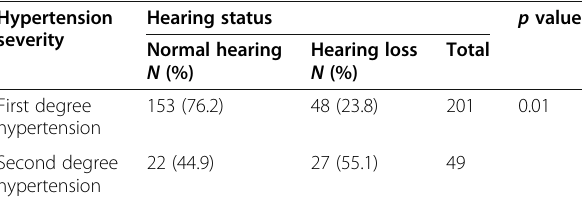
Table 2 Degree of hypertension and distribution of hearing status among the participants